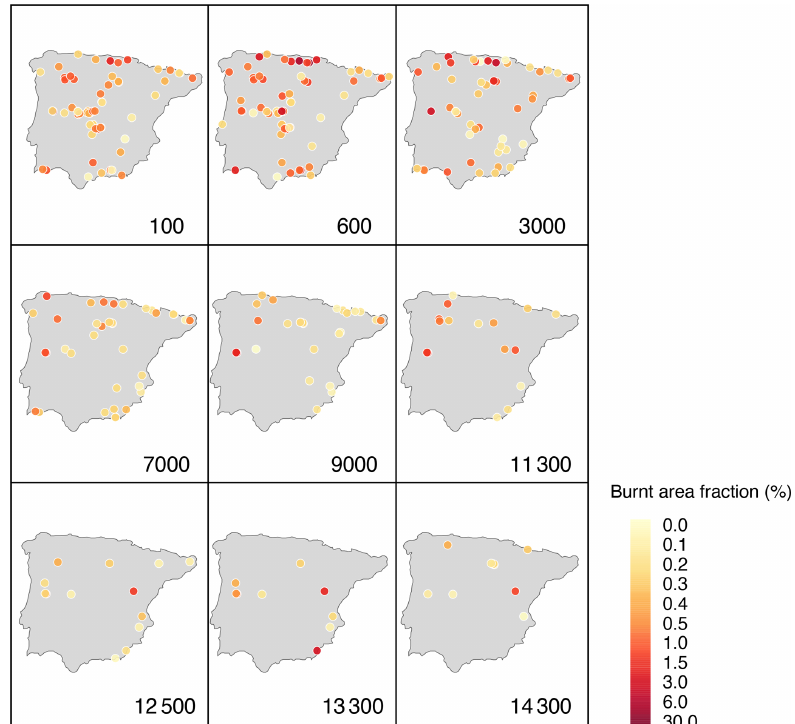
Figure 7. Spatial patterns of reconstructed burnt area fraction at key times in the